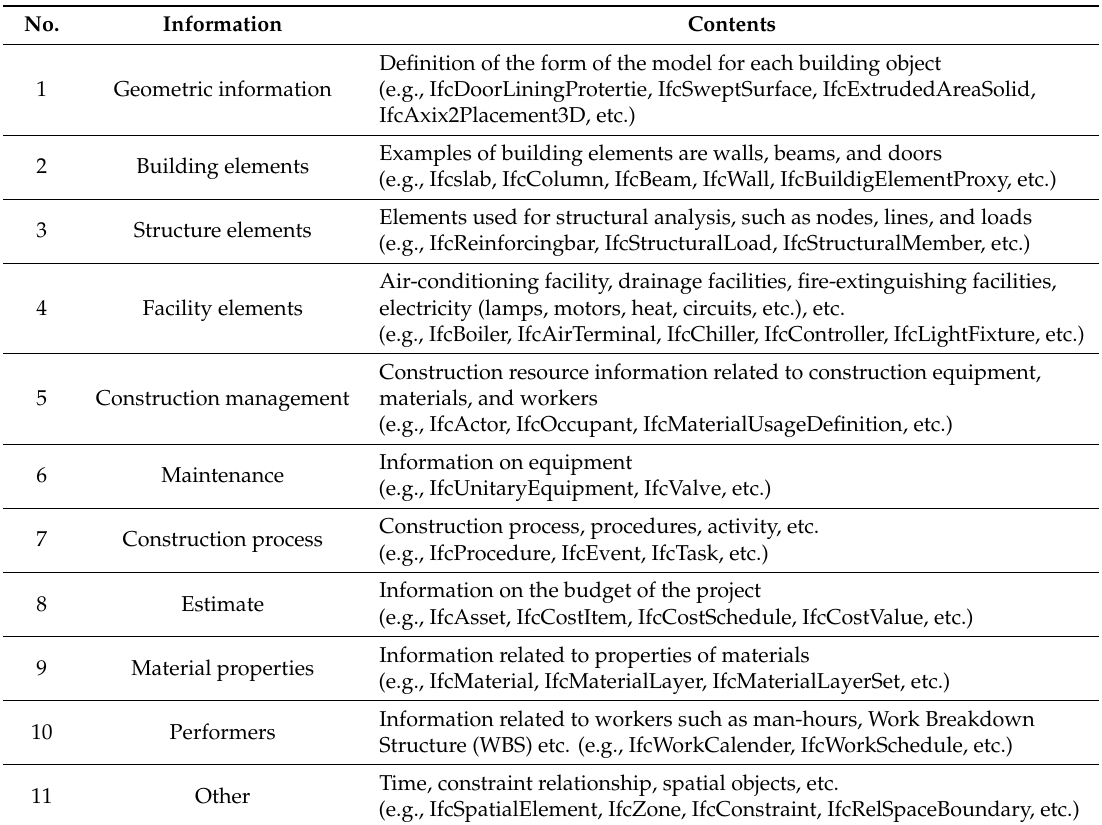
Table 1. Information type of industry foundation classes